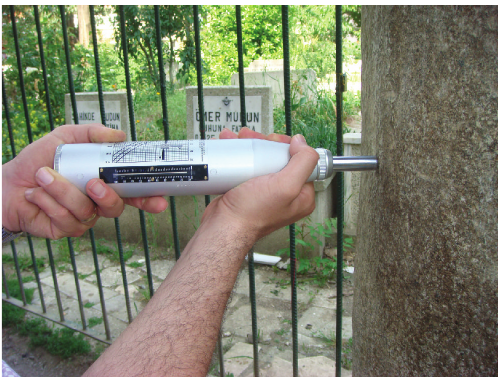
Figure 4: Schmidt hammer